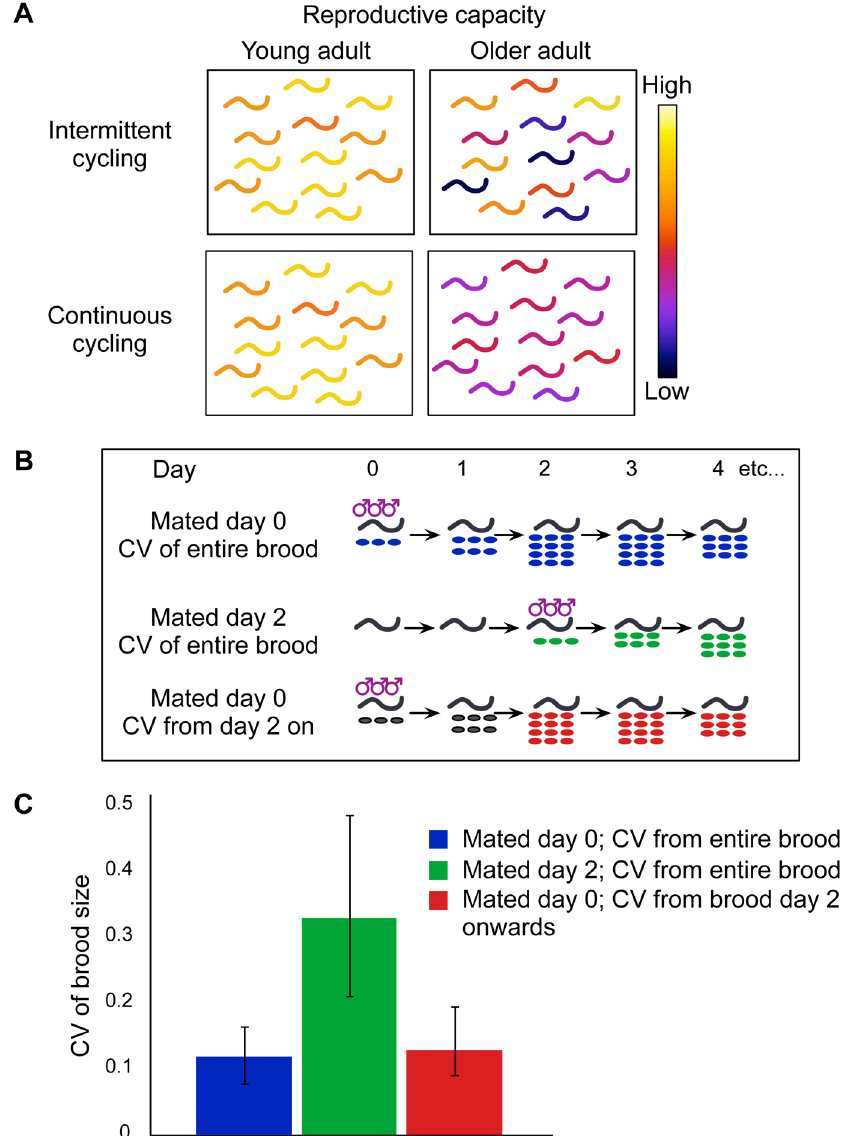
Fig 7. Variability of remaining reproductive capacity in aging populations. (A) According to a model by which gonads switch stochastically between dormant and active states, and according to which activity leads to progressive loss of reproductive capacity, there may be an increase with age in the population-level spread of remaining reproductive capacity. Color coding for worms is based on remaining reproductive capacity (lookup table on right). (B) Schematic of experiments used to measure reproductive capacity CV. (C) Reproductively-inactive female populations undergo an increase in reproductive capacity CV. Error bars represent 99% confidence intervals; for details see S6